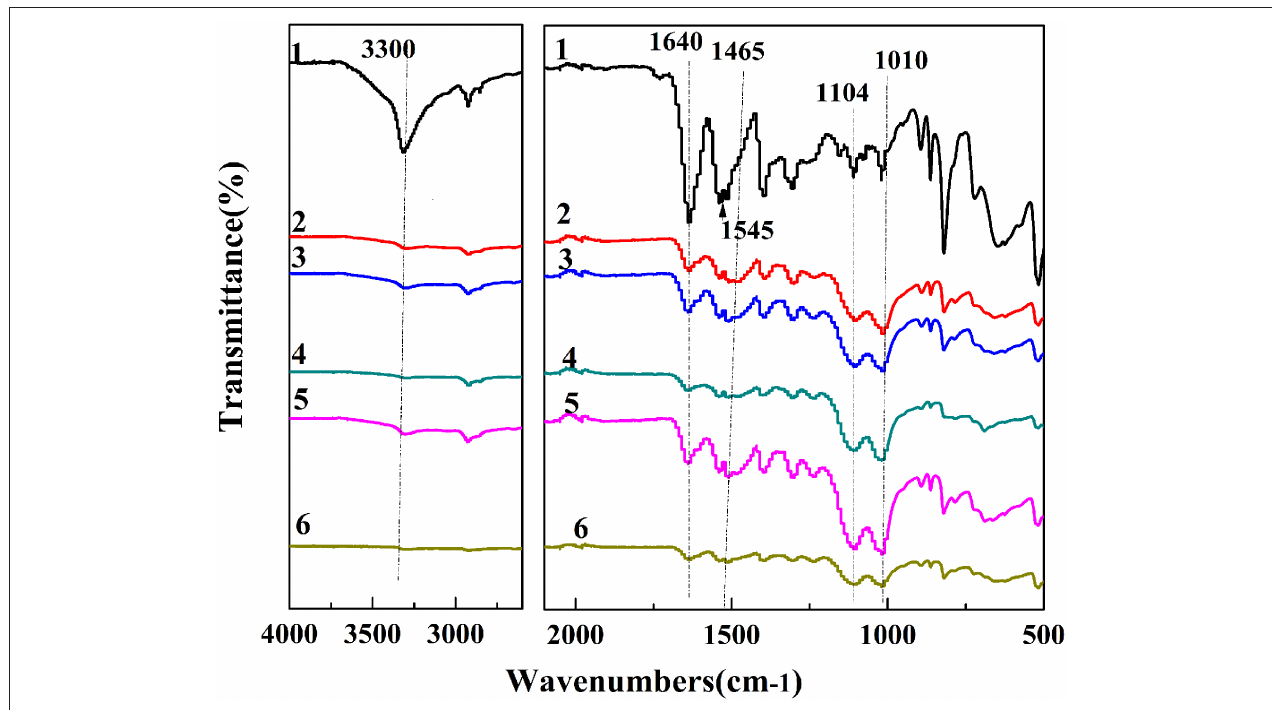
FIGURE 1 | IR spectra of PPTA and PPTA-AM samples. PPTA (1), PPTA-AM-90 (2), PPTA-AM-70 (3), PPTA-AM-50 (4), PPTA-AM-30 (5), and PPTA-AM-10